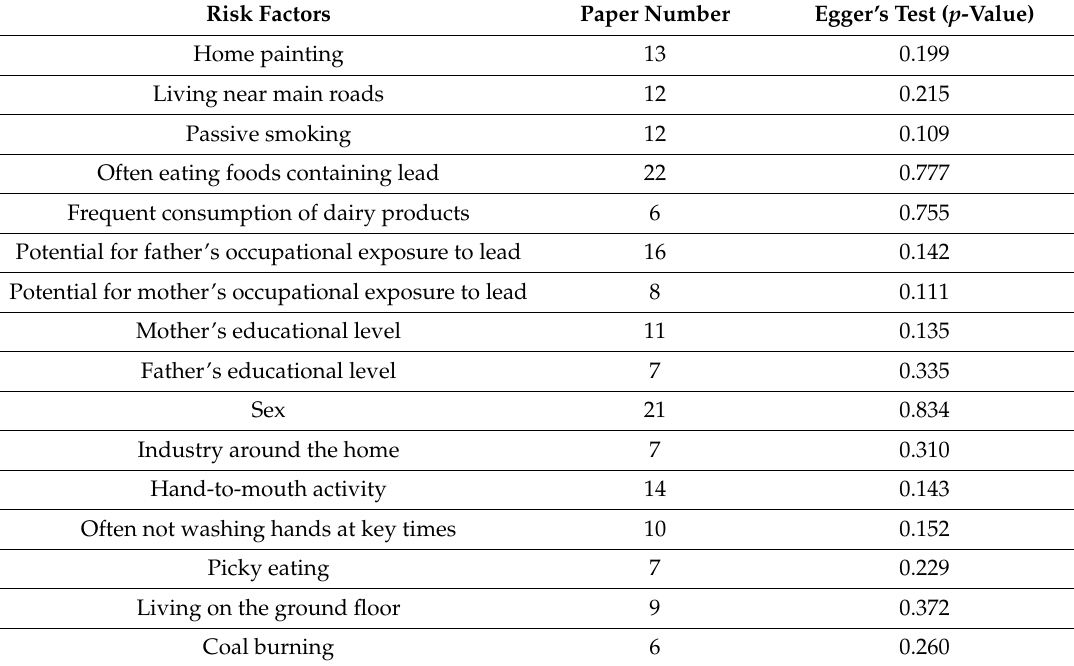
Table 4. Publication bias of the risk factors for child lead poisoning in